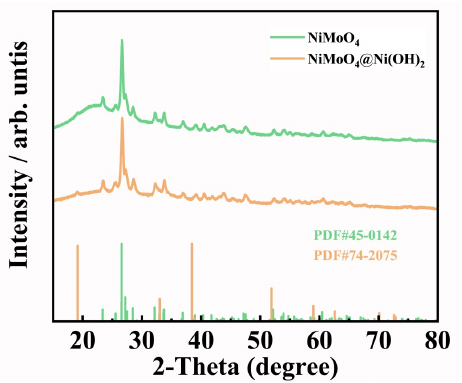
Figure 2. XRD patterns of the NiMoO 4 and NiMoO 4 @ Ni(OH) 2 nanofibers.